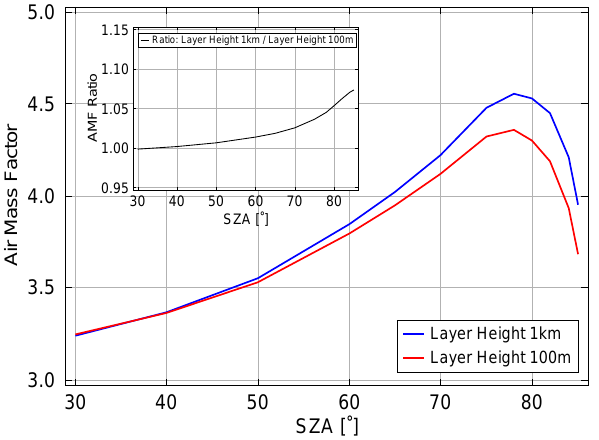
Fig. 2. Calculated AMF for IO using the SCIATRAN radiative transfer code for a Rayleigh atmosphere at 425nm above a 90% reflecting surface. Two different layer heights (LH) are compared, with constant VMR in this layer above the surface, LH=1 km in blue and LH=100 m in red. The inset shows the ratio of the two AMF calculations, i.e. AMF (LH 1km) / AMF (LH 100m). The maximum difference between the two cases lies below 7%.